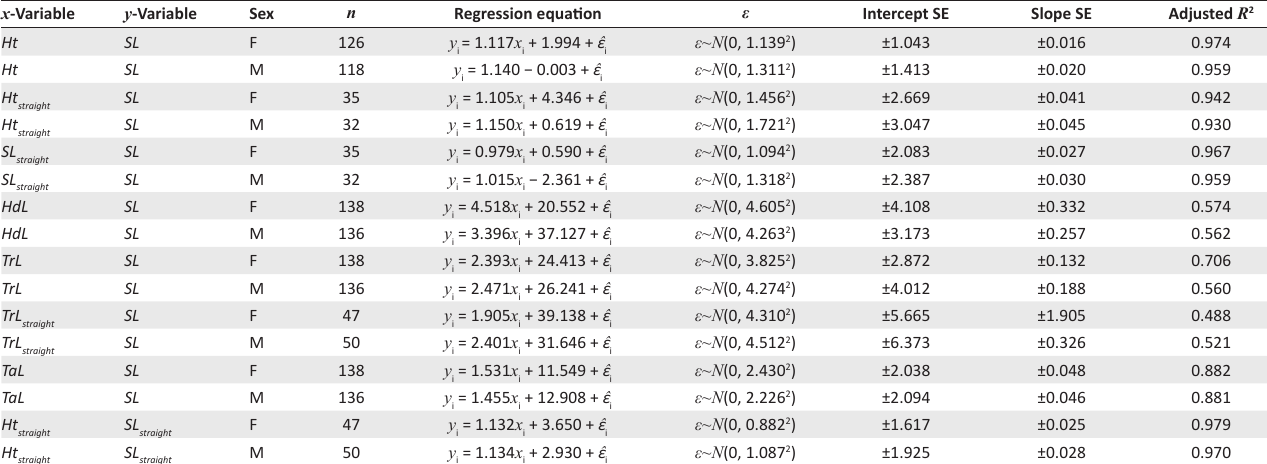
TABLE 2: Correlation between selected morphometric characteristics of Hippocampus capensis collected in